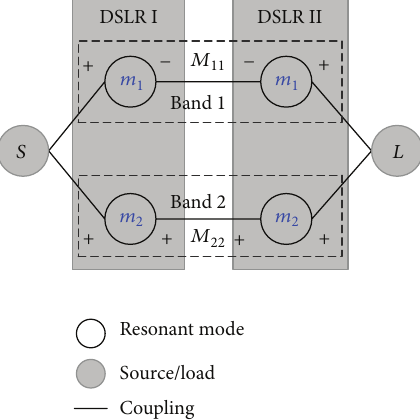
Figure 5: Coupling schematic of the designed dual-band